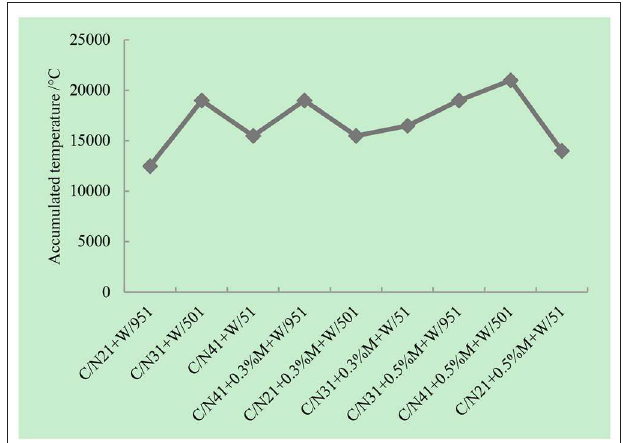
FIGURE 4 | Compost accumulated temperature of different